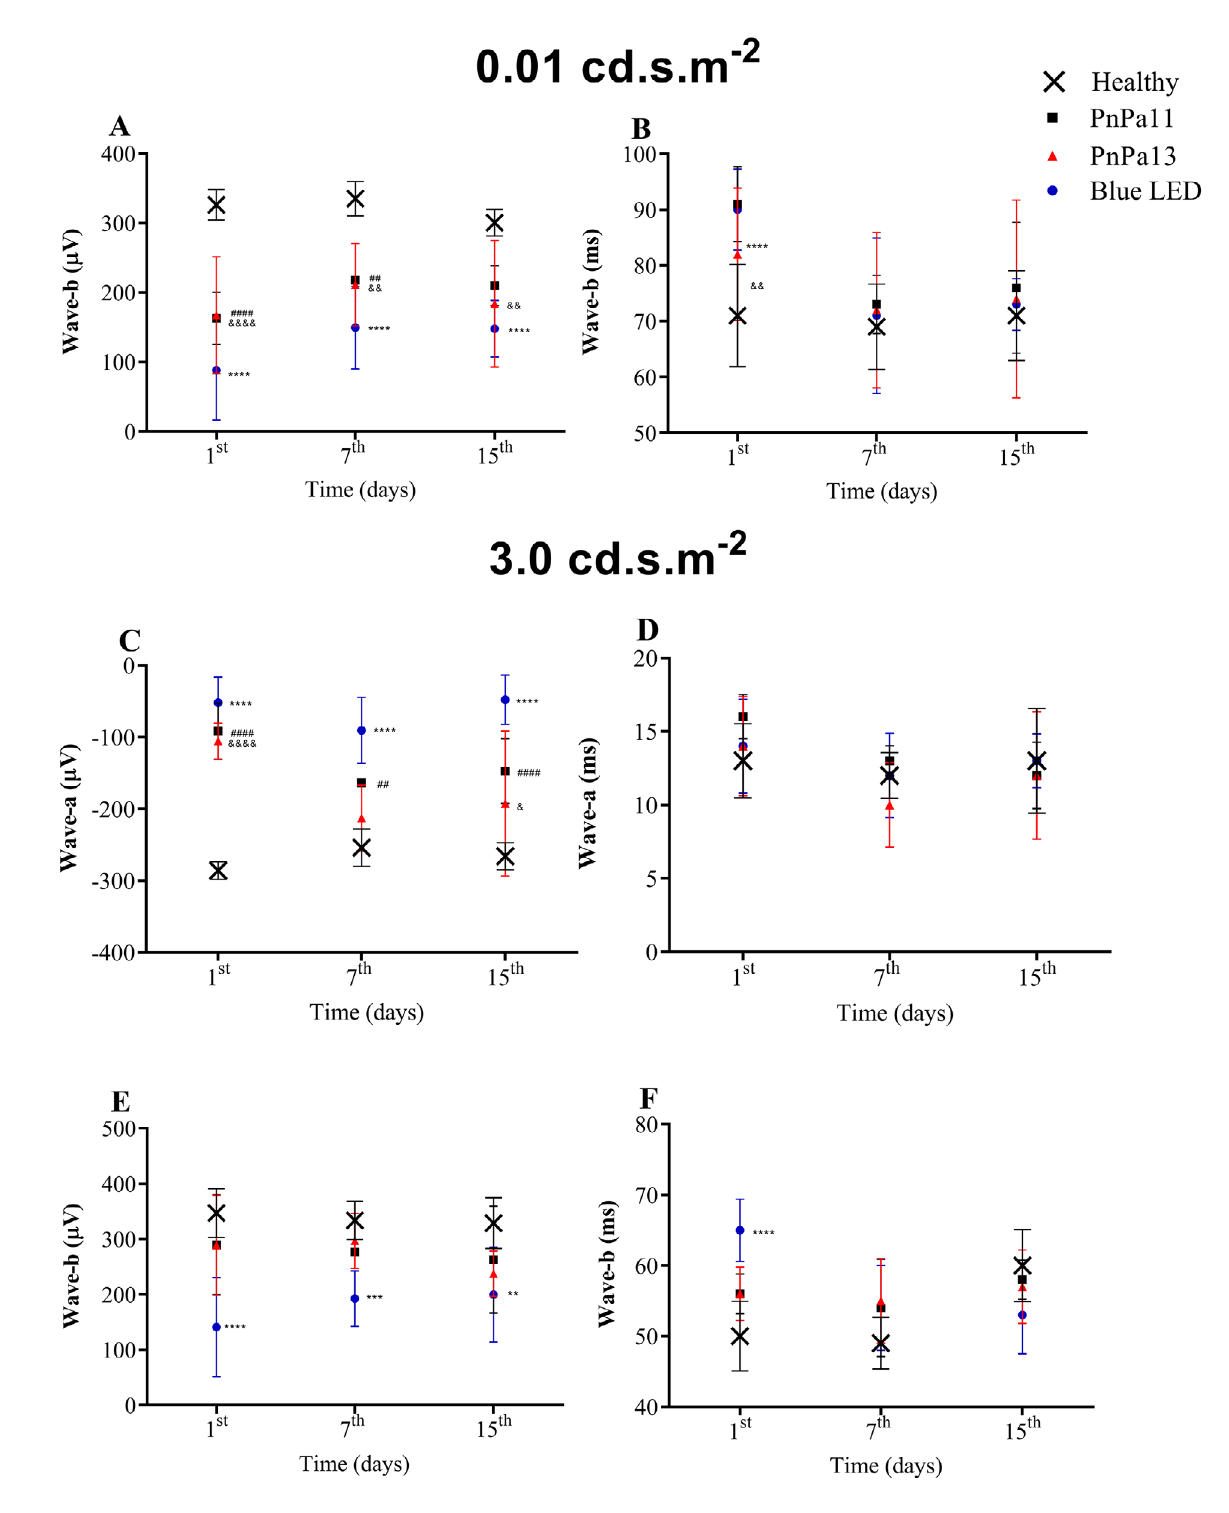
Figure 4. Media ± SD of a- and b- wave amplitude and implicit time at scotopic condition. (A) b-wave amplitude at luminous intensity of 0.01 cd·s·m −2 . (B) b-wave implicit time at luminous intensity of 0.01cd·s·m −2 . (C) a-wave amplitude at luminous intensity of 3.0 cd·s·m −2 . (D) a-wave implicit time at luminous intensity of 3.0 cd·s·m −2 . (E) b-wave amplitude at luminous intensity of 3.0 cd·s·m −2 . (F) b-wave implicit time at luminous intensity of 3.0 cd·s·m −2 . Data represent the means ± SD (n = 8). Comparison among groups was calculated using two-way ANOVA followed by Bonferroni post-test. *Significant differences as compared blue LED with healthy (**p < 0.01, ***p < 0.001, ****p < 0.0001). # Significant differences as compared PnPa11 with healthy ( ## p < 0.01, #### p < 0.0001). & Significant differences as compared PnPa13 with healthy ( & p < 0.05, && p < 0.01, &&&& p <